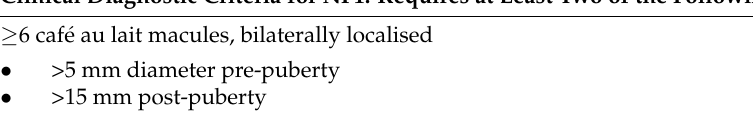
Table 1. Clinical diagnostic criteria for